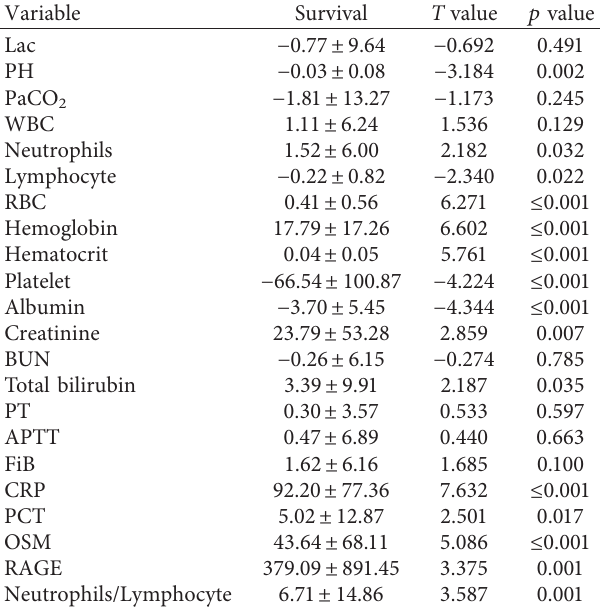
Table 7: Laboratory examination results before and after one-week treatment in the survival group.